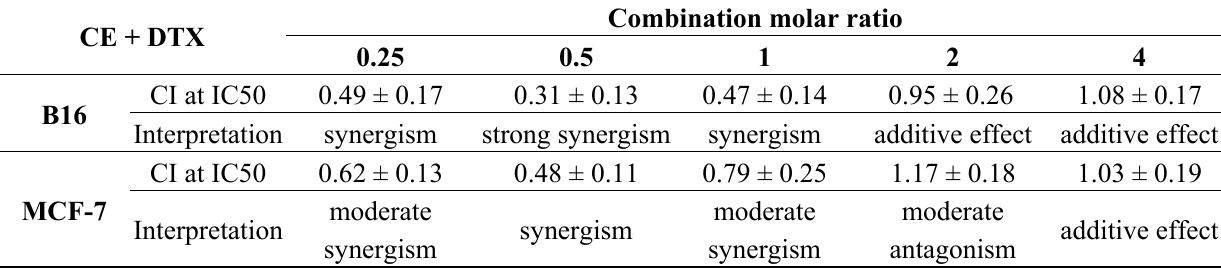
Table 1. Combination index (CI) values of CE + DTX with different combination molar ratio at 50% growth inhibition point on B16 and MCF-7 cells ( n =